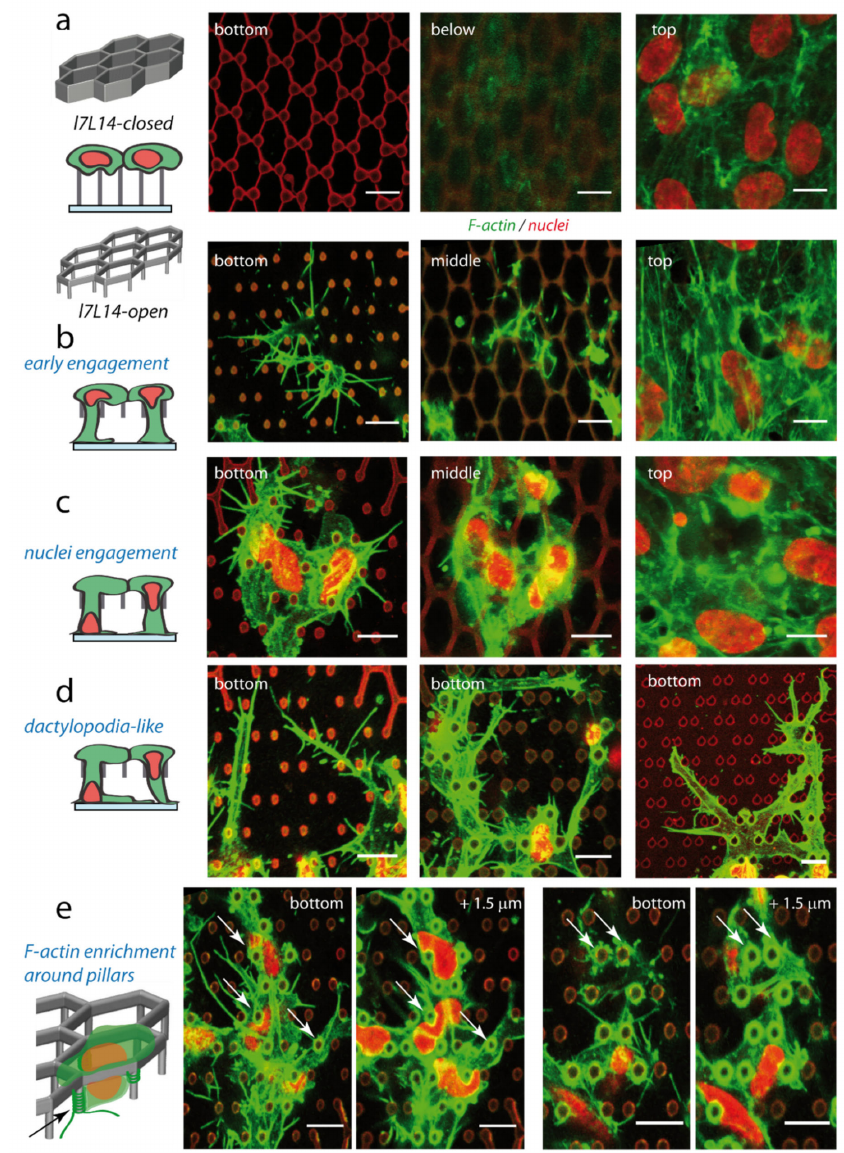
Figure 3. HUVECs organization on closed and open microstructures. Left, schemes of hexagonal lattices, and side or 3D views of typical HUVECs organization after colonization. Right, confocal planes, denoised images, scale bar 10 µ m. Red: nuclei and microstructure autofluorescence, green: F-actin. Cells were cultivated in standard conditions (VEGF 0.5 ng/mL) unless otherwise specified. Cells were fixed at time of structure colonization (2 ( b , d -middle, d -right), 3 ( d -left) or 4 ( a , c ) days after cell seeding). ( a ) Closed microstructures. Confocal planes on HUVECs on l7L14-closed microstructure. Left, bottom plane (contact with the bottom substrate); middle, just below the structure (1.2 µ m below the top of the structure); top, above the structure. ( b – e ) Typical examples of colonization of open l7L14-open structures, with vertical engagement and formation of filopodia in the bottom plane: ( b ) with limited cell area on the basal substrate), ( c ) with larger membrane and nuclei vertical engagement, ( d ) with formation of extended, dactylopodia-like protrusions, and ( e ) typical en- richment observed for F-actin around the micropillars, white arrows. ( b , c ) From left to right, bot- tom plane; middle plane (at the level of the closed part of the structure); top, above the structure. ( d ) Dactylopodia-like protrusions were observed without ( d -left) or with ( d -middle,right) VEGF in the media. Bottom planes are shown. For d -left, correspondent membrane labelling with bottom, middle and top views is shown in Figure A3c. ( e ) Two examples of bottom and top planes are